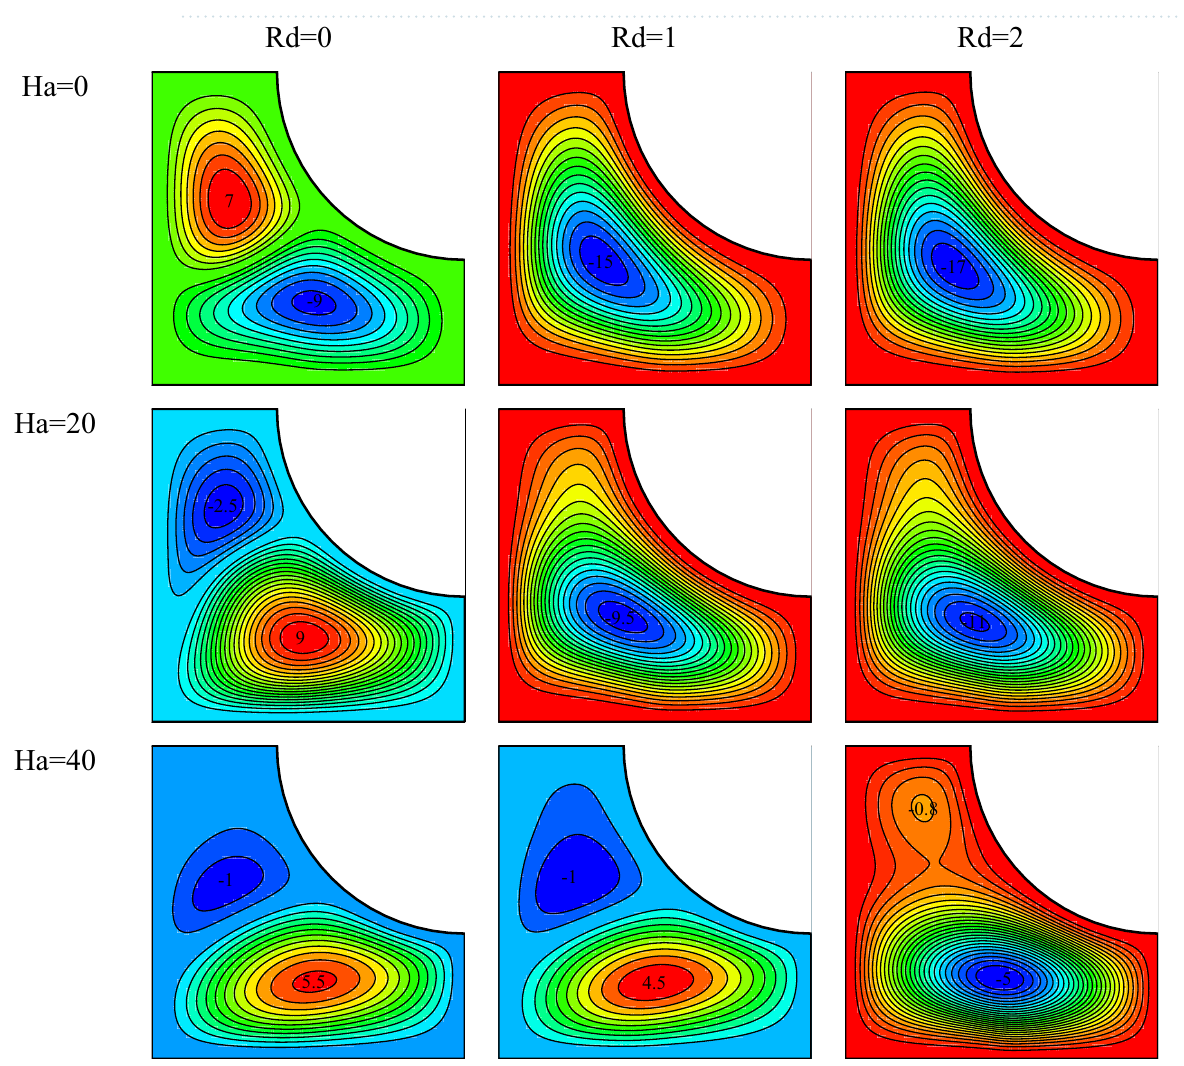
Figure 9. Flow field for Ra = 10 5 , ω = 0, ϕ = 0.03, γ = 45 ◦ and various Hartmann numbers and radiation